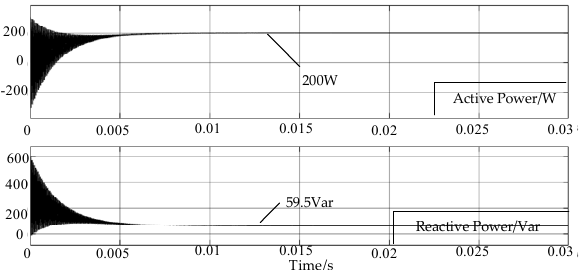
Figure 20. φ AD = 25.8° and φ AB = 152° active power and reactive power waveforms. Figure 20. ϕ AD = 25.8 ◦ and ϕ AB = 152 ◦ active power and reactive power waveforms. Observe the ZVS of each bridge arm, as shown in Figures 21–23 below. Observe the ZVS of each bridge arm, as shown in Figures 21–23 below.